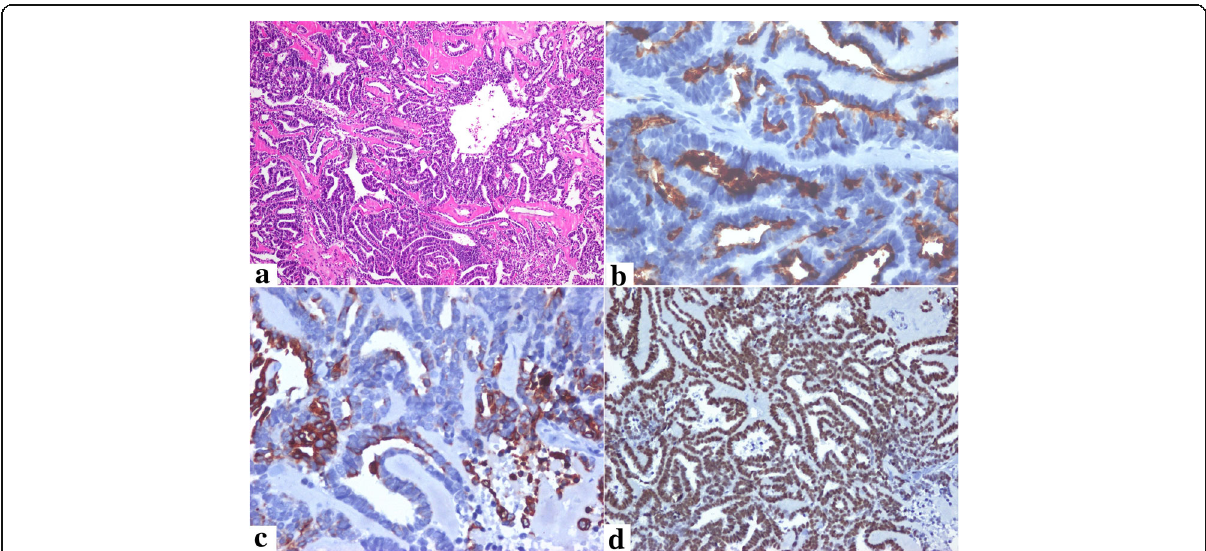
Fig. 1 Mesonephric Adenocarcinoma of the Cervix. Epithelial neoplasm with a tubular, ductal, and papillary growth pattern producing intraluminal eosinophilic secretory material, located on a densely hyalinized stroma [HE 20 X] ( a ). The tumor cells were positive for CD10 (luminal pattern), keratin 7, and PAX2 ( b , c , d